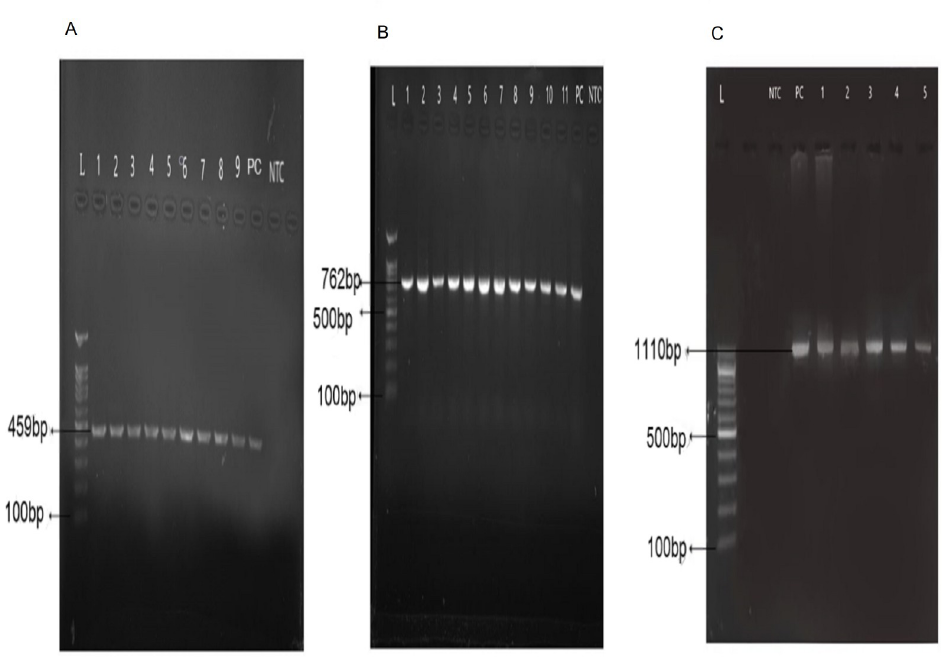
Fig 2. Agarose gel electrophoresis of amplified gyrA , gyrB and rrl genes. DNA ladder was used to proximate the gene sizes in agarose gel electrophoresis. (NTC) no template control, (PC) positive control. (A) the amplification of gyrA gene (459 bp), (B) the amplification of gyrB gene (762 bp) and (C) the amplification of rrl gene (1110bp).